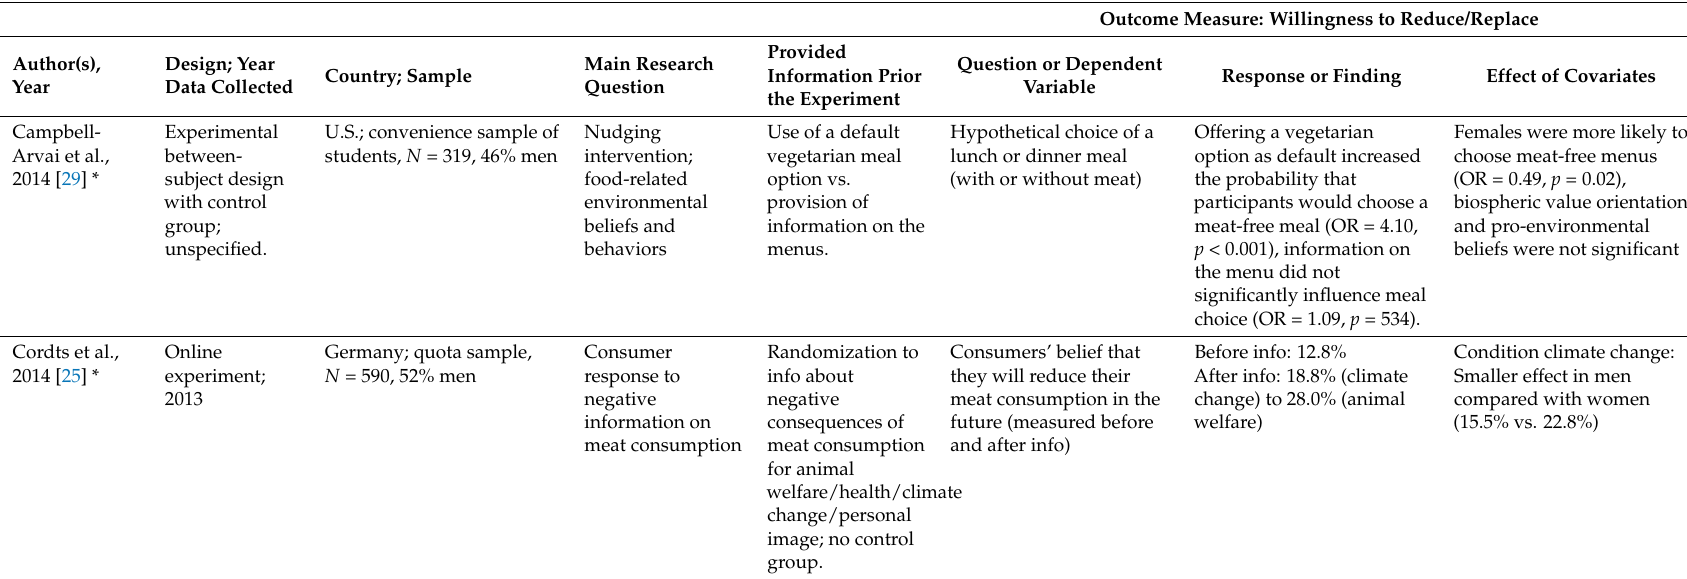
Table A2. People willingness to stop or reduce meat consumption because of its environmental